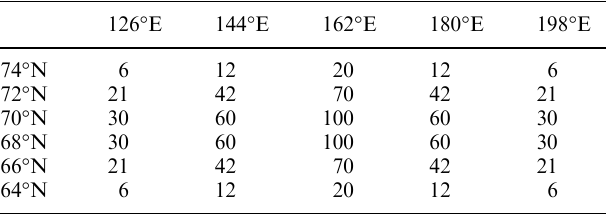
Table 1. Electric field enhancements (in mV/m) at specified grid points in the Northern Hemisphere